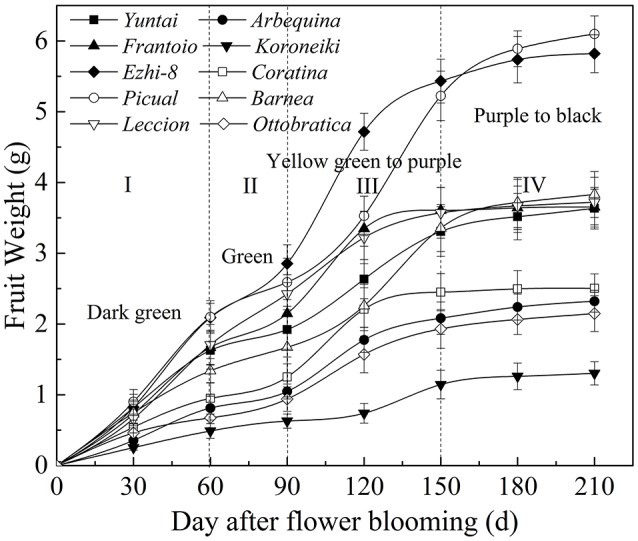
Olive fruit weight and color change during growth and ripening.